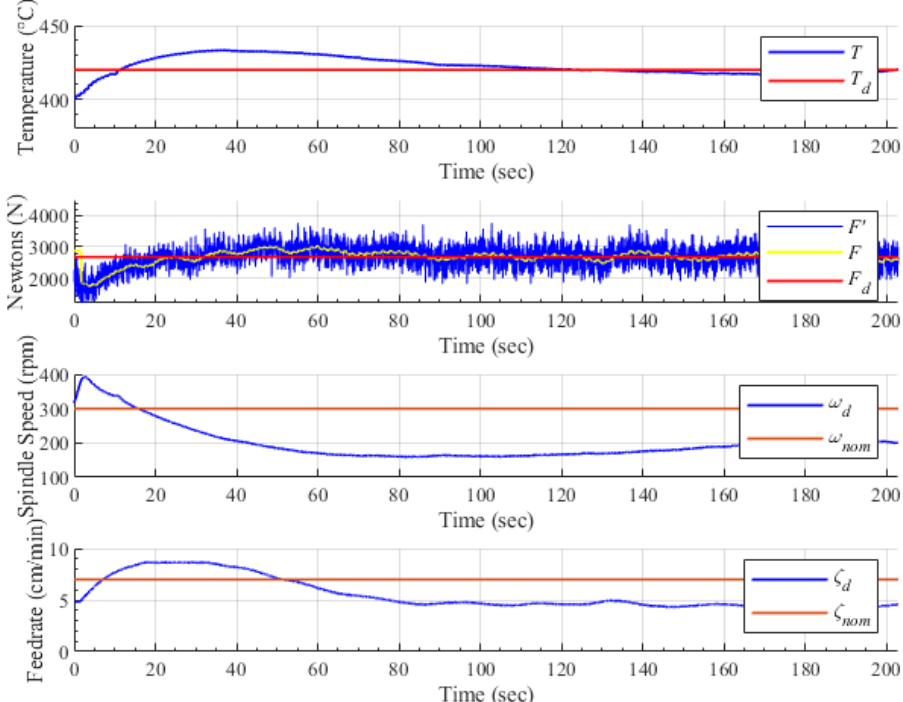
Figure 14. Protocol G. ( Top ) The desired versus measured temperature. A maximum error of 13.2 ◦ C occurs at t ≈ 35 s. ( Middle Top ) The desired versus measured force. A maximum error of 367.9 N occurs at t ≈ 45 s. ( Middle Bottom ) The desired and nominal spindle speeds. ( Bottom ) The desired and nominal